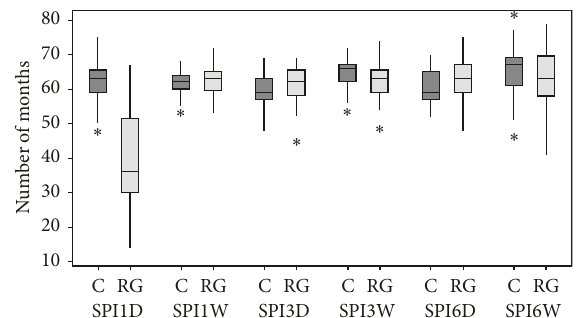
Figure 6: Boxplot of the number of months with dry and wet conditions (SPInD and SPInW, respectively, with n 1-month, 3- (cid:31) month, and 6-month timescale) for the SPI based on CHIRPS estimations (C) and rain gauges (RG) observations. Dry months were defined when SPI 1.0, and wet months were defined when SPI 1.0. Each boxplot shows the median and first and third quartiles, while the whiskers extend to the data values that are 1.5 ≤− times the interquartile range above or below the quartiles. Outliers ≥ are represented by ∗